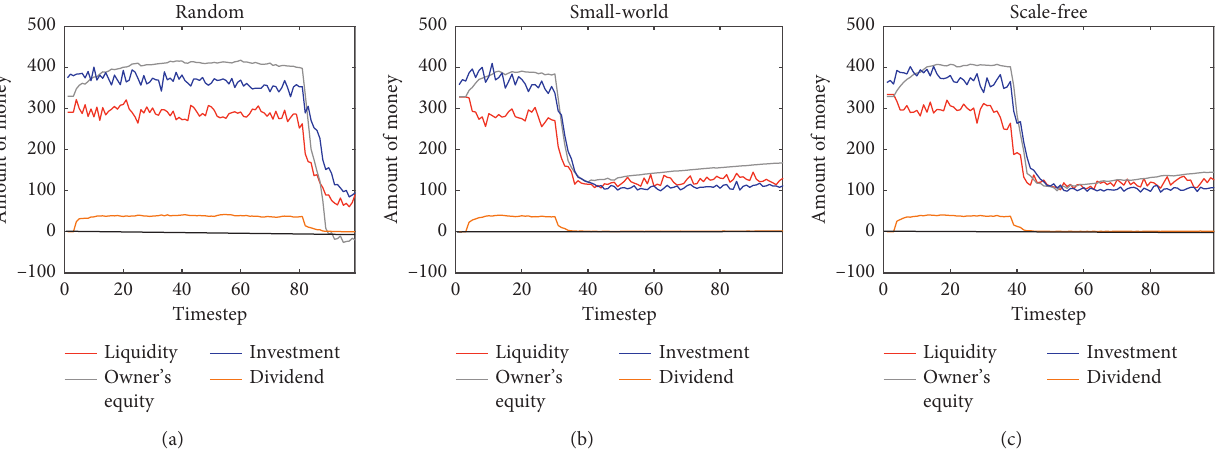
Figure 2: The evolutionary process of a bank under diverse interbank networks.